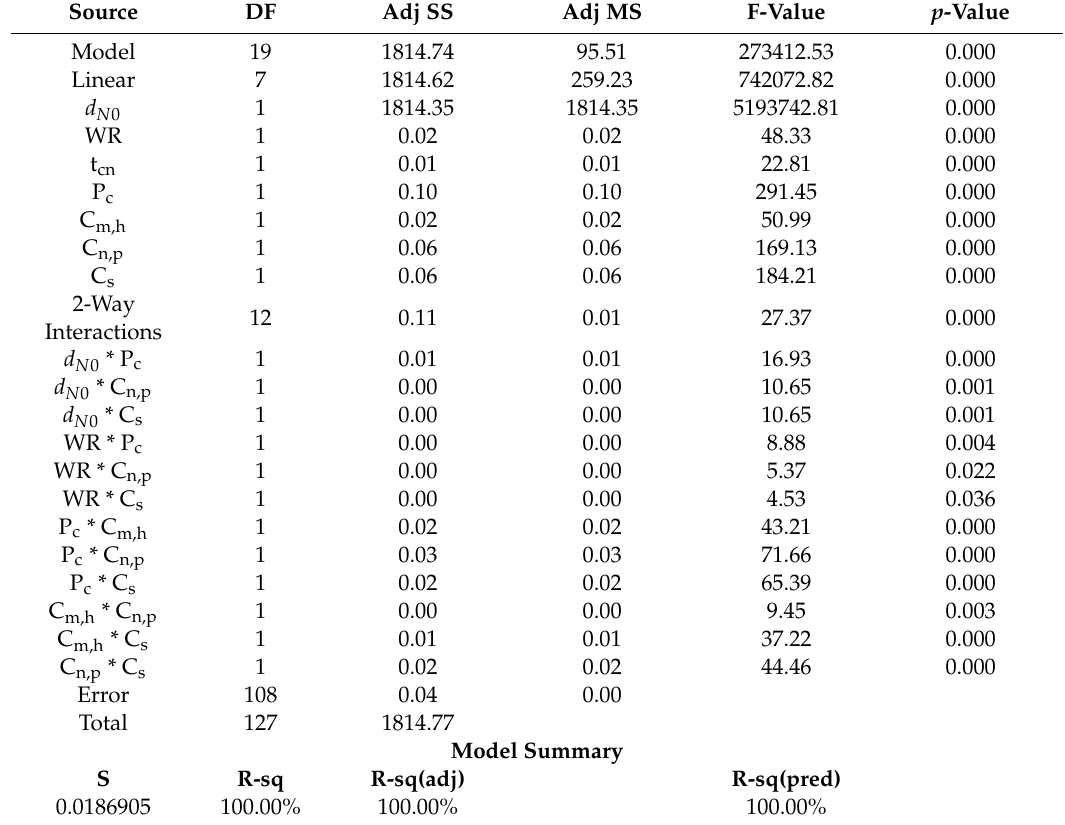
Table 4. Analysis of Variance.